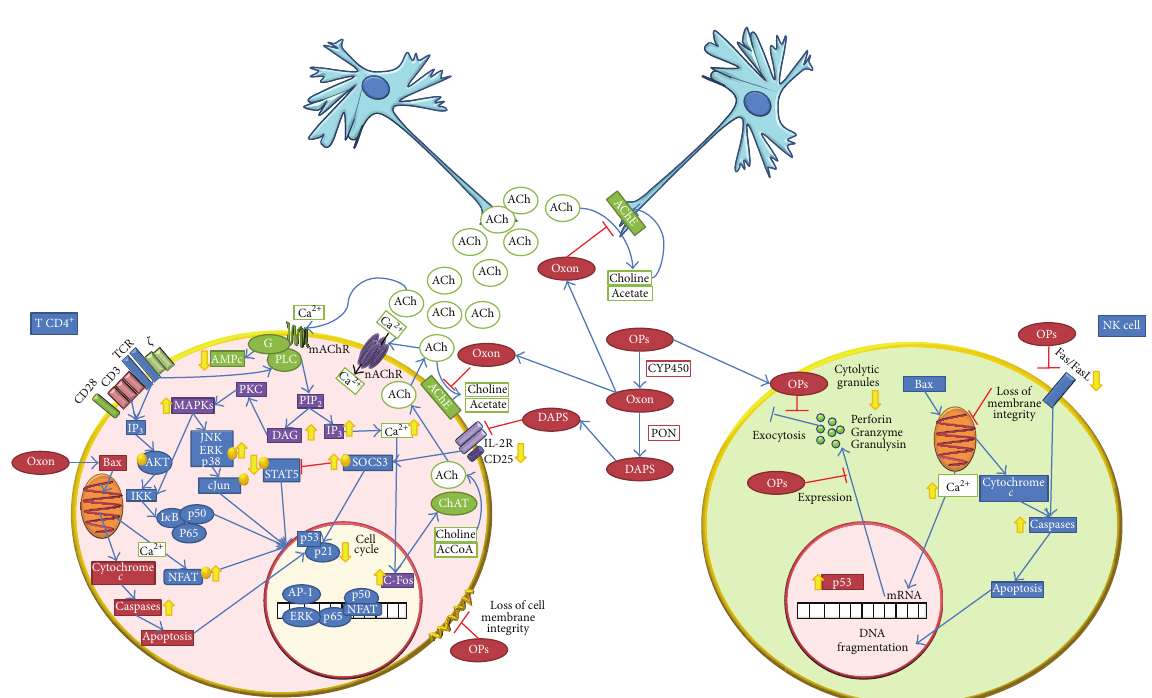
Figure 1: Mechanisms of immunotoxicity of OPs. The potential immunotoxicity mechanisms could involve effect directly on immune cells or through neuroimmune communication disturbance. AcCoA: acetyl-coenzyme A; ACh: acetylcholine; AChE: acetylcholinesterase; ChAT: acetylcholine transferase; CYP450: Cytochrome P450; DAPS: dialkylphosphates; mAChR: muscarinic acetylcholine receptor; nAChR: nicotinic acetylcholine receptor; OPs: organophosphorus pesticides; oxon: oxidized metabolite of OPs; PON: